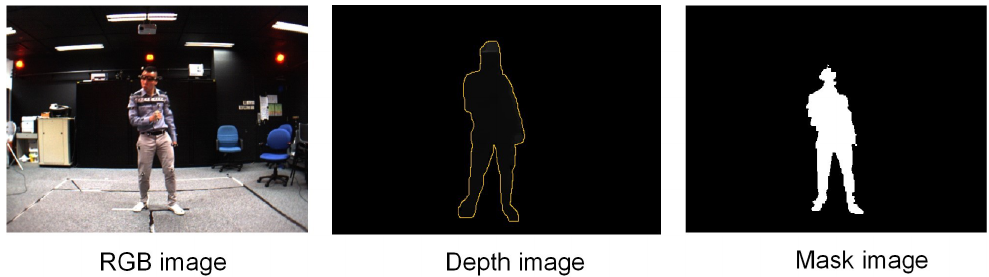
Figure 4. Illustrating of 3D human annotation data correction results according to point cloud data based on the human mask from the image. The red human skeleton is a result of 3D human pose estimation in the point cloud data.